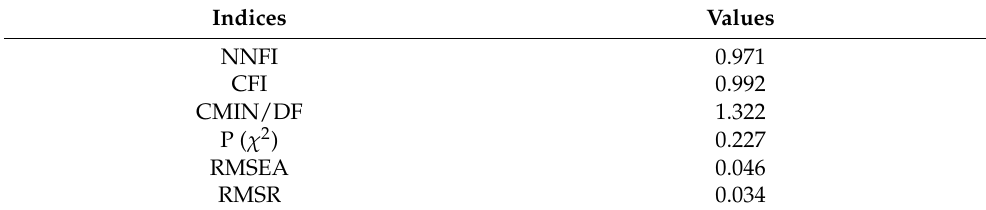
Table 6. Goodness of fit indices.